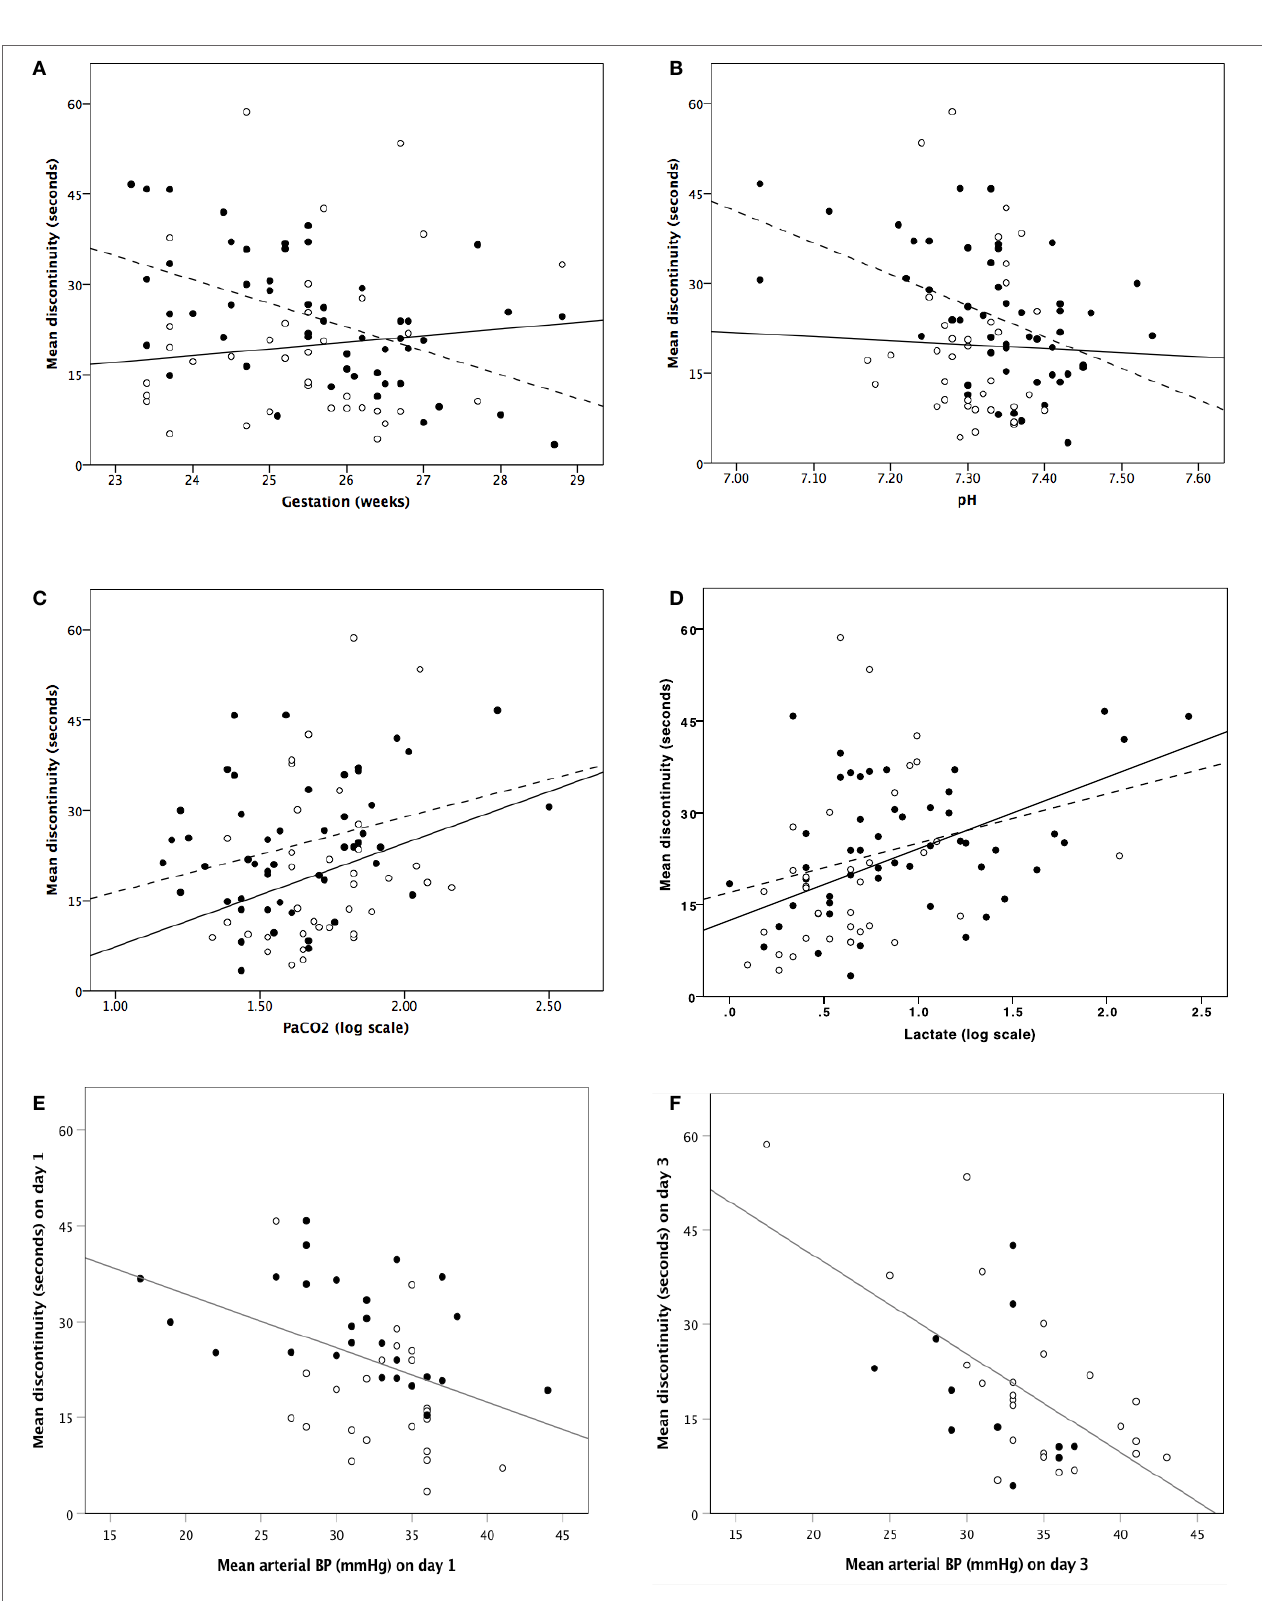
FigUre 2 | Correlation between mean discontinuity and gestation (a) , pH (B) , PaCO 2 [log scale] (c) , lactate [log scale] (D) , and invasive mean blood pressure (e,F) . (a–D) Closed dots and dashed regression line represent day 1 and open dots and solid regression line represents day 3. (e,F) Closed dots represent infants who received inotropes and open dots represent infants who did not receive